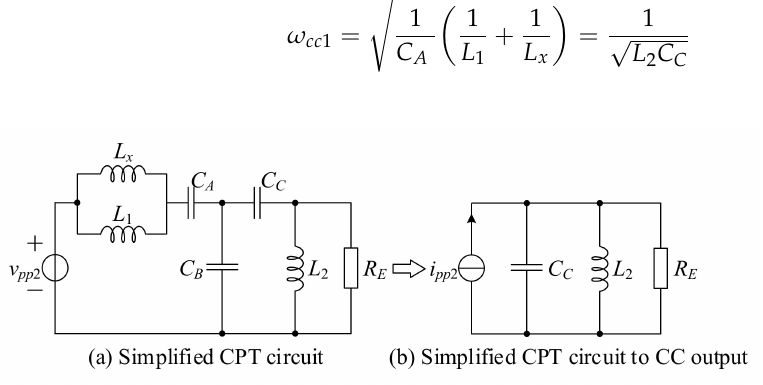
Figure 12. The simplified L x -PP CPT circuit using the T-type model to realize CC